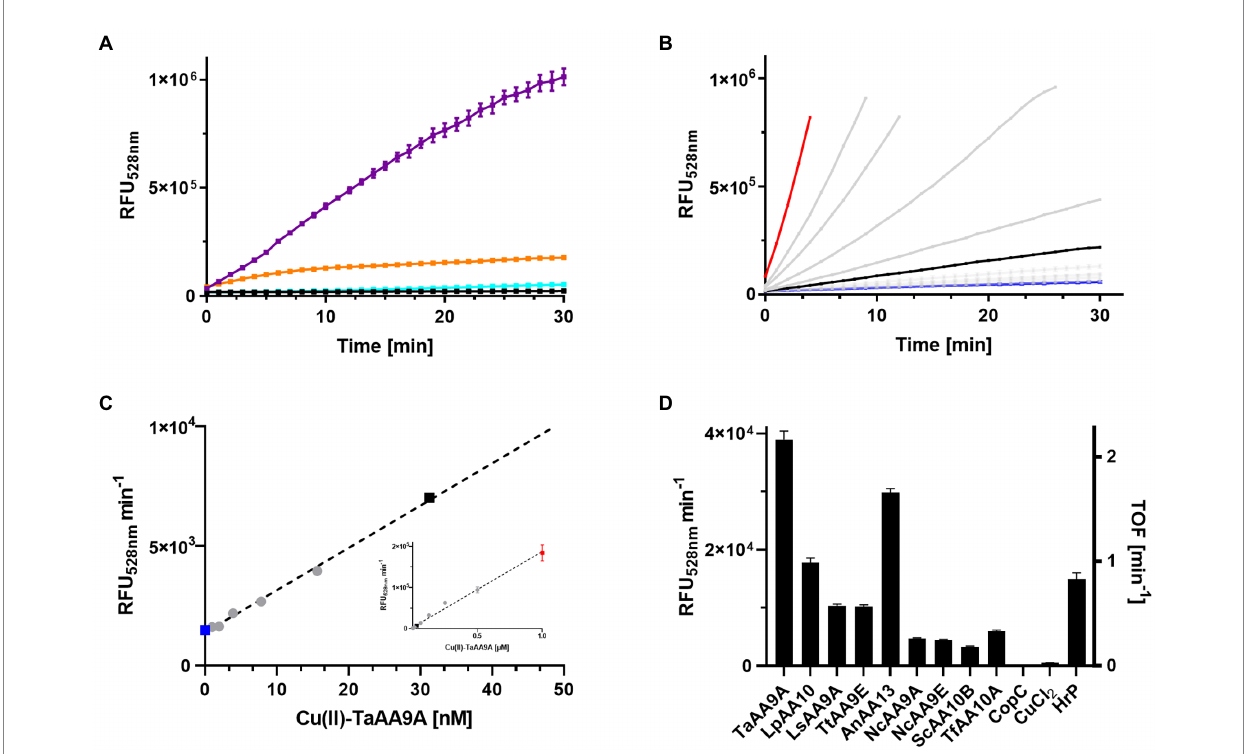
FIGURE 2 Oxidation of rFl by LPMOs. (A) Fluorescence progress curves from incubating samples of 100 nM Cu- Ta AA9A (purple), Cu(II)- Ls AA9A (orange), CuCl 2 (cyan), or water (black) with 6.35 μ M rFl, 100 μ M DHA, and 100 μ M H 2 O 2 in citrate–phosphate buffer at pH 7.25. (B) Fluorescence progress curves of similar reactions as in (A) , but varying the concentration of Cu(II)- Ta AA9A (0–1 μ M). The highlighted data are 1 μ M (red), 30 nM (black) and 0 (blue) Cu(II)- Ta AA9A. (C) The initial slopes of the curves in (B) are plotted against their enzyme concentration over the range (0–50 nM). The insert shows the complete titration curve from 0–1 μ M Cu-TaAA9A. (D) A series of LPMOs were tested in the same assay conditions as in (A) together with 100 n M CuCl 2 and 100 nM HRP. The initial rates based on these conditions are shown on the left y-axis and the turnover frequency numbers on the right